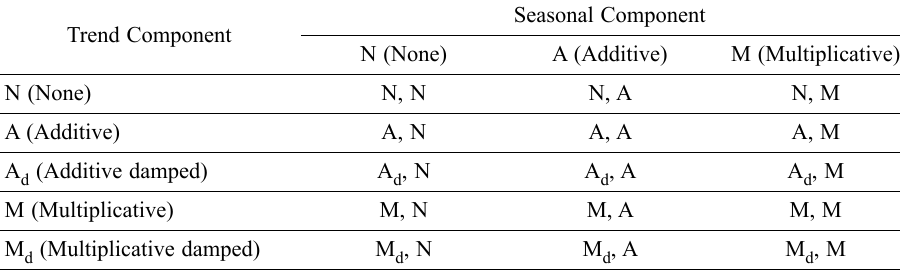
Table 1. All the combinations of trend and seasonality components Seasonal Component Trend Component N (None) A (Additive) M (Multiplicative) N (None) N,